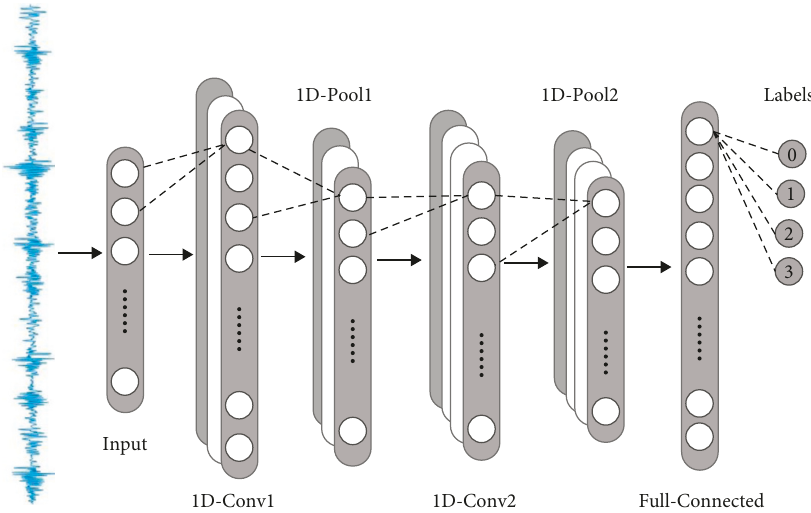
Figure 1: The structure of one-dimensional convolution.